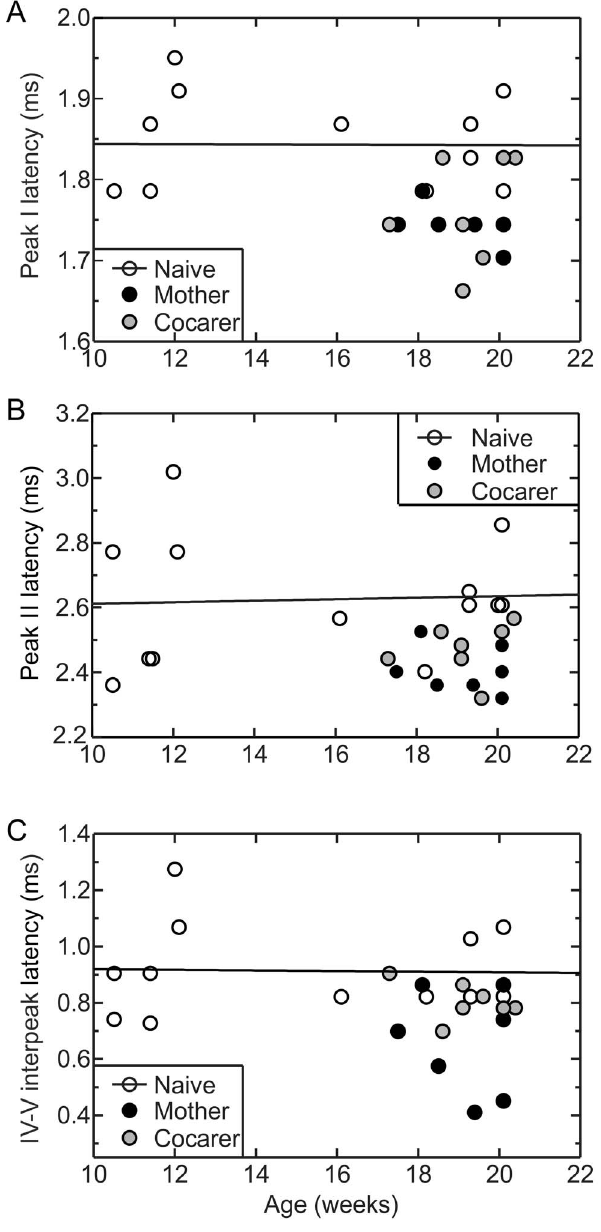
Figure 3. Shorter click-evoked ABR latencies in mothers represent a genuine shift towards faster processing. A) Peak I and B) peak II latencies, and C) IV–V interpeak latencies as a function of age, measured 20 dB above each animal’s threshold. For these peaks, which differed significantly between pup-naive females and mothers, pup-naive females did not show any age-related latency shift. Trend lines refer to pup-naive points only. r 2 for all panels is , 0.001. Data points for mothers and cocarers are all below these trend lines.